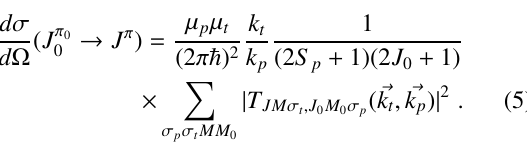
Figure 4. Predicted excited states of 90 Zr calculated to be popu- lated via the 92 Zr(p,t) 90 Zr reaction.